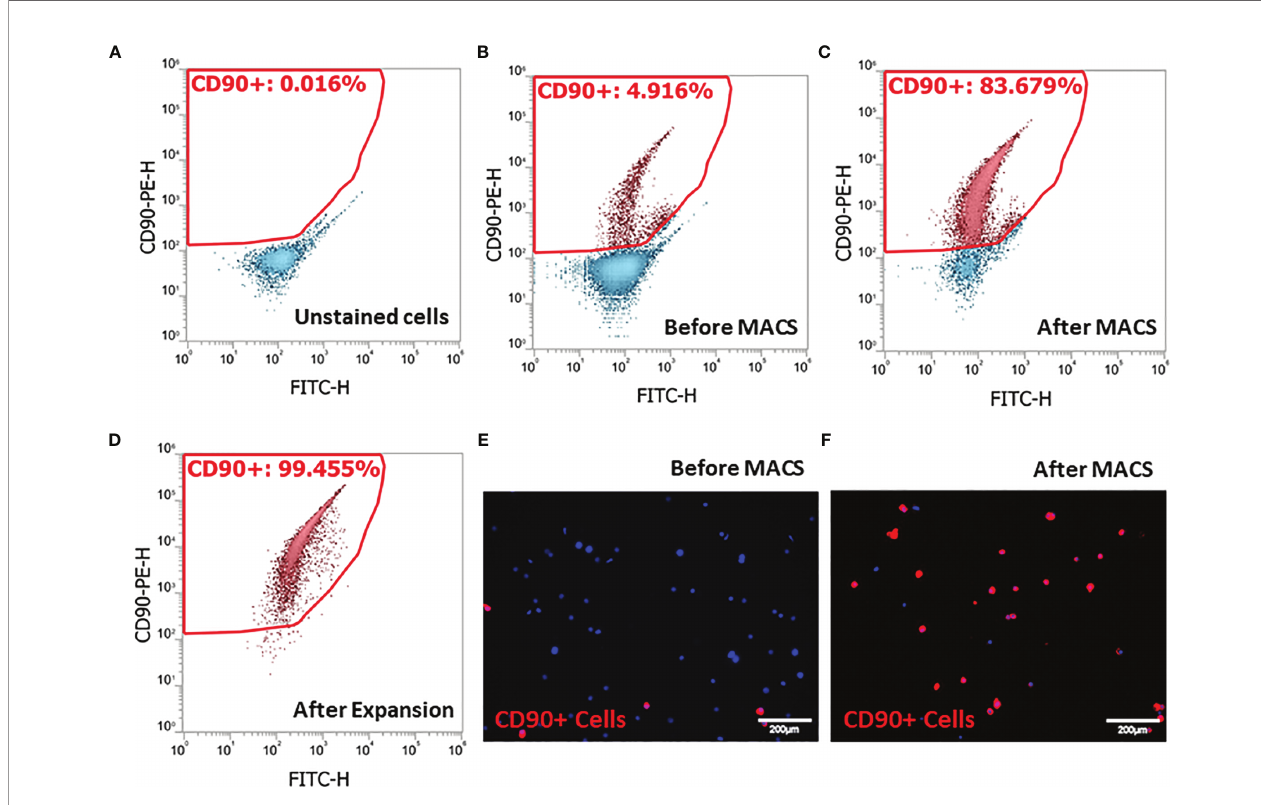
FIGURE 1 | Isolation of stem Leydig cells by the surface marker CD90: (A) unstained testicular cell suspension. (B) Testicular cell suspension stained with PE-CD90 antibody before isolation by magnetic-activated cell sorting (MACS). (C) PE-CD90 antibody-stained cells after MACS. (D) CD90+ cells after their culture in vitro for 7 days. (E) CD90+ cells before MACS. (F) CD90+ cells after